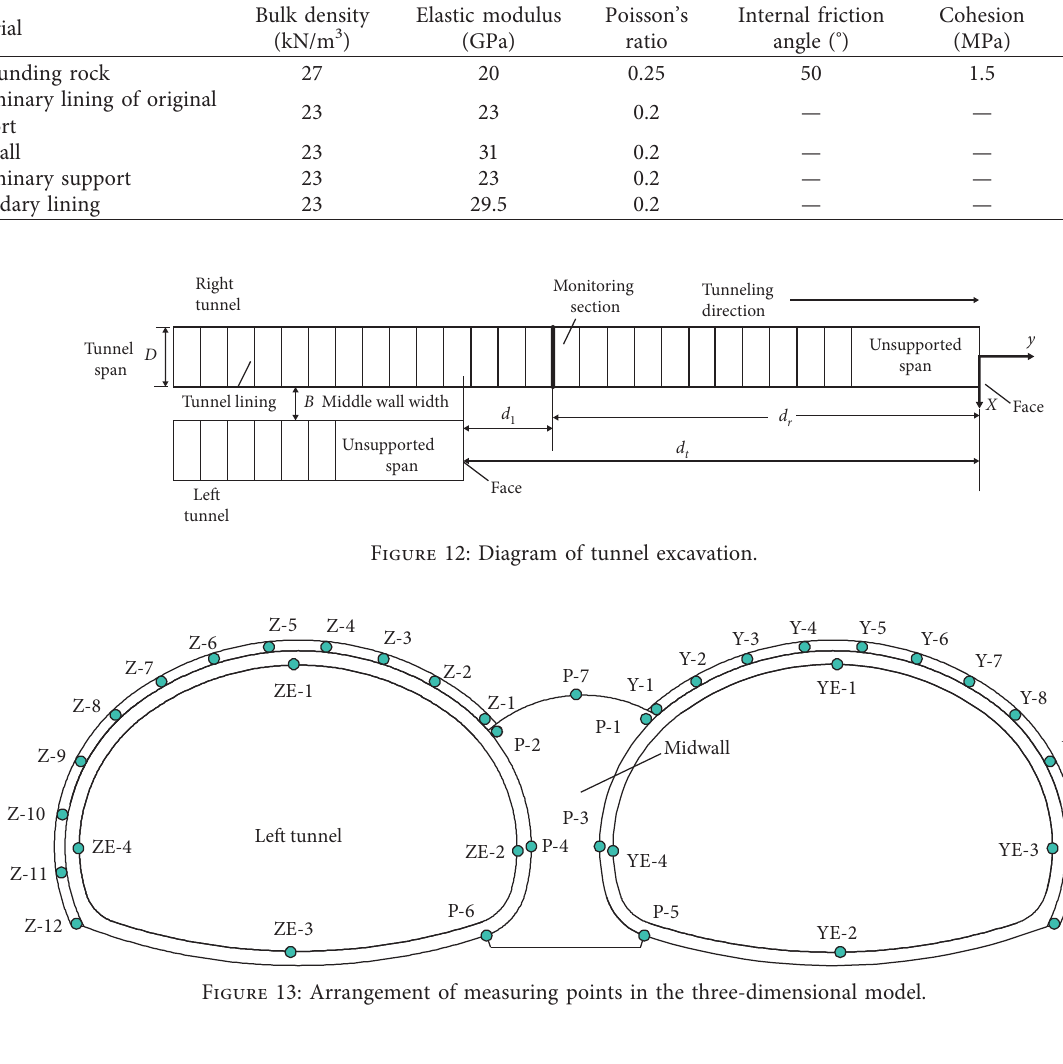
Table 5: Parameters of surrounding rocks and supports.